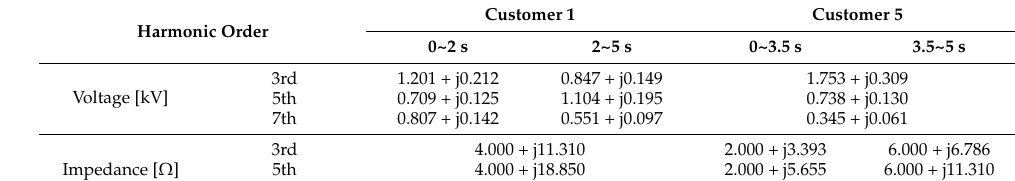
Table 2. The equivalent parameter changes on two customers 1 and 5.